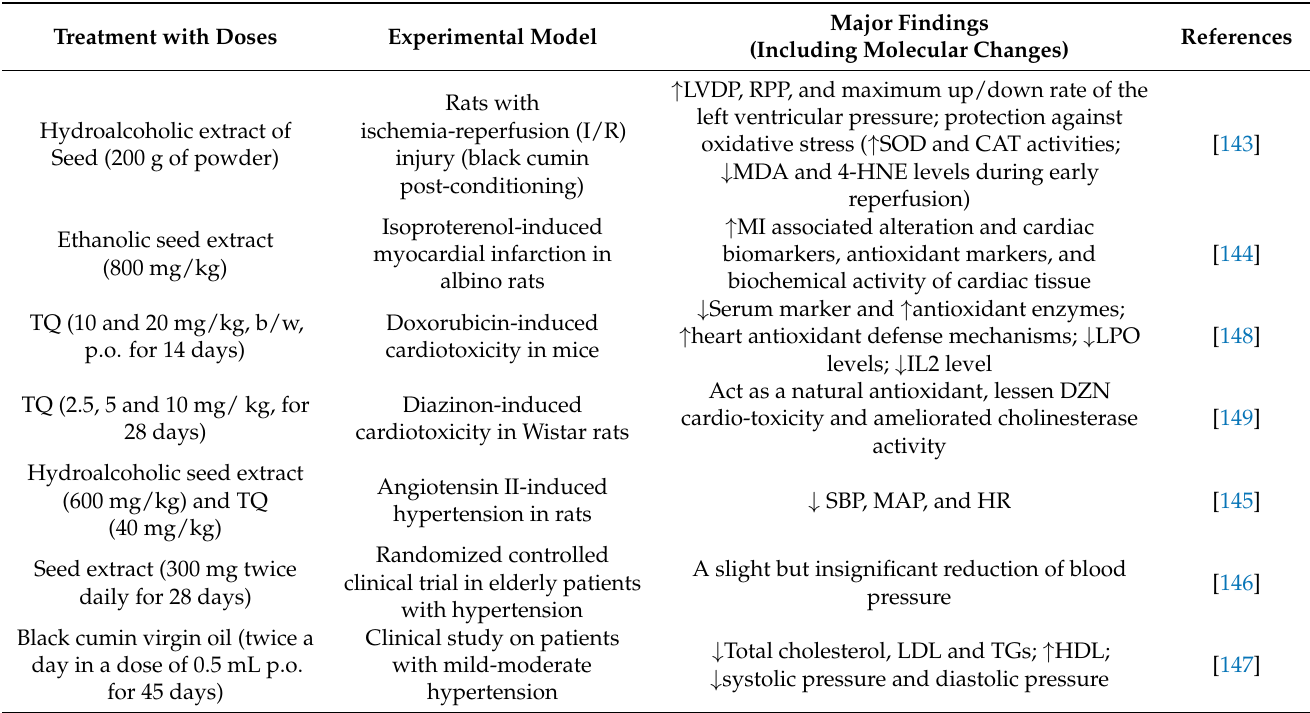
Table 5. Comprehensive summary on the cardioprotective and antihypertensive effects of black cumin. Treatment with Doses Experimental